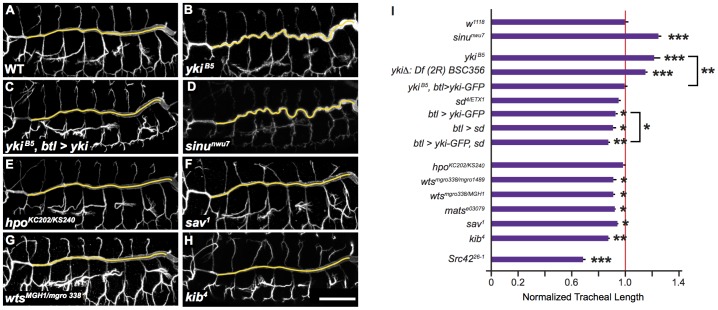
Yorkie and the Hippo Pathway Regulate Tracheal Tube Size.(A–D) Maximum projections of confocal sections showing tracheal lengths. Compared to stage 16 WT embryos (A), ykiB5 mutant trachea (B) have an over-elongated phenotype similar to the SJ mutant sinu (D). Expression of UAS-yki in the trachea of ykiB5 mutants rescues tracheal length defects (C). Yellow lines indicate dorsal trunk measurements. Tracheal lumens visualized by anti-2A12 marker staining. (E–H) Although embryos trans-heterozygous for hpo mutations have WT tracheal length (E), mutations in Hippo pathway components sav, wts and kib shorten tracheal length (F–H, respectively). (I) Quantification of tracheal length shows that decreased Yki activity lengthens trachea, while increased Yki activity or decreased Hpo pathway activity reduces tracheal length. Tracheal length was measured in three dimensions in confocal stacks, normalized to embryo length and then normalized to WT (w1118, red line). Error bars show normalized s.e.m.; *: p<0.05; **: p<0.005; ***: p<0.0005. p-values determined using Student's t-test. Scale bar for (A–G) in (H), 50 µm.